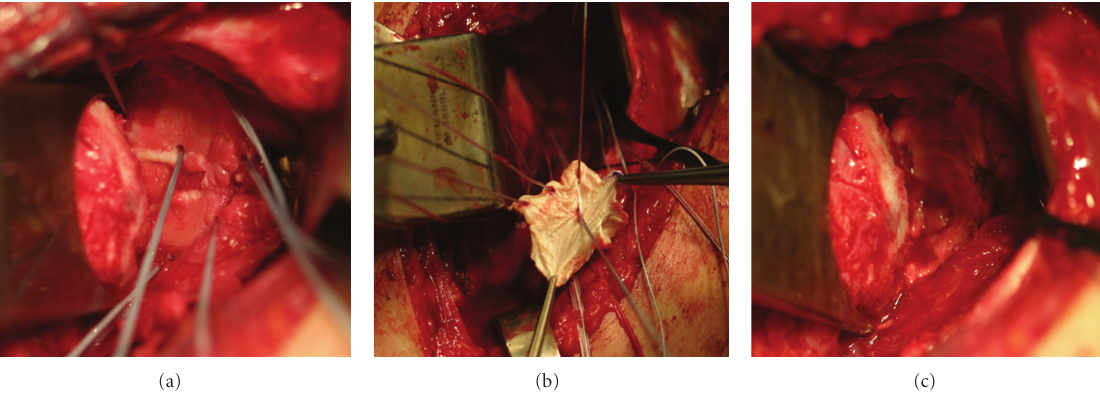
Figure 6: Preparation of the glenoid (a) for soft-tissue (b) resurfacing of the glenoid in a patient younger than 50 years old with a glenoid cartilage defect